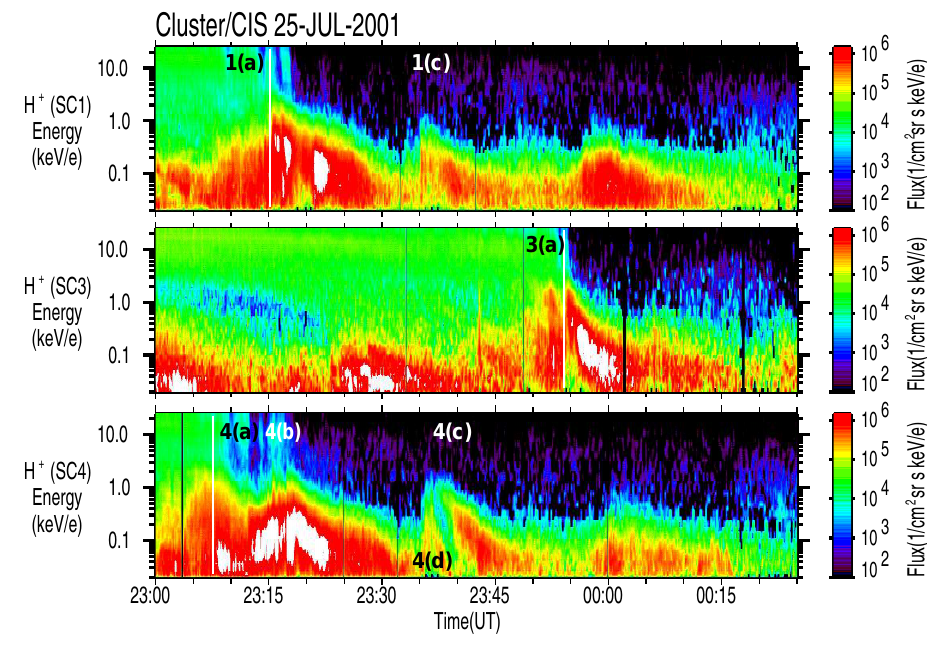
Plate 1. Cluster/CIS observation for the cusp crossings on 25 July 2001. Plotted are H + omnidirectional flux measurements (1/(cm 2 ssrkeV/e)) for satellite SC1, SC3 and SC4. All satellites encounter distinctive structures, sudden jumps in the ion energy dispersion that are similar on SC1 and SC4 but different on the later arriving SC3